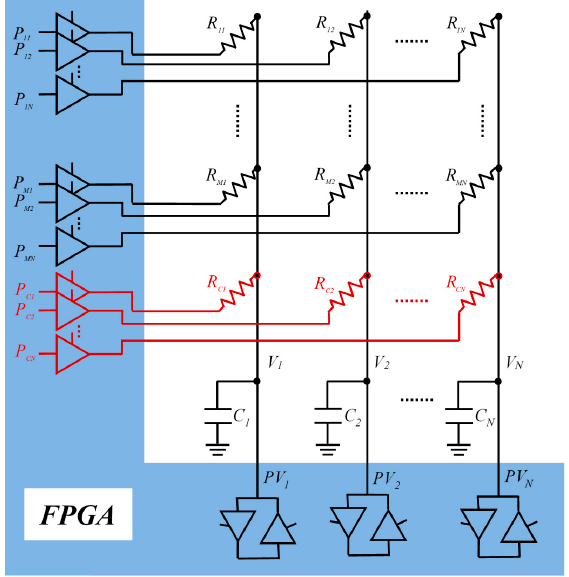
Figure 1. Direct interface resistive sensor array-FPGA.